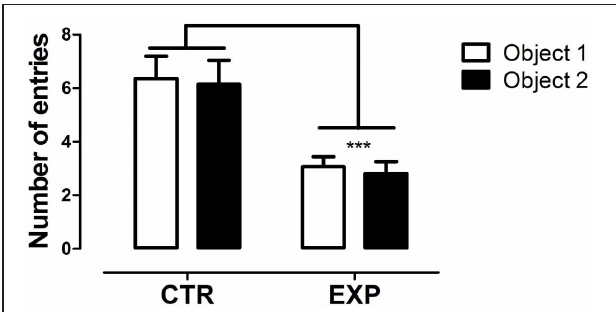
FIGURE 1 | Number of entries into compartments with objects is shown as mean ± standard error. Control group (CTR) n = 14 and Experimental group (EXP), n = 16. The number of entries between compartments did not differ for both groups, but EXP exhibited less number of entries into both compartments. ∗∗∗ p < 0 .